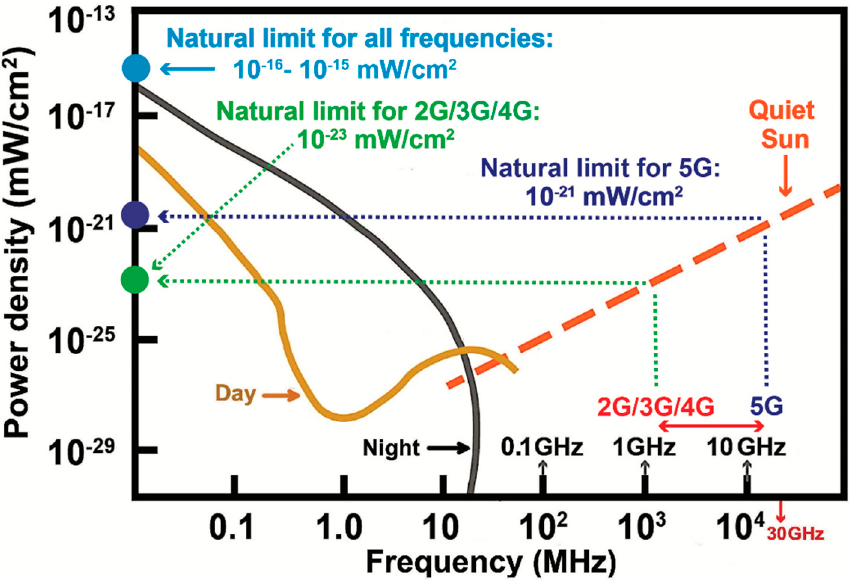
Figure 1. Day and night natural limit of power density (mW/cm 2 ) of EMR emitted by the reaching Earth’s surface in the microwave spectral regions, from 0.1 to 3 × 10 4 MHz. The associated Sun and reaching Earth’s surface in the microwave spectral regions, from 0.1 to 3x10 4 power density natural limit of ~10 − 23 to 10 − 21 mW/cm 2 is compared with the ICNIRP exposure MHz. The associated power density natural limit of ~10 − 23 to 10 − 21 mW/cm 2 is compared limit of ~1 mW/cm 2 for man-made microwave sources. The ICNIRP/FCC thermal exposure limit for with the ICNIRP exposure limit of ~1 mW/cm 2 for man-made microwave sources. The man-made EMR is ~10 21 - to 10 23 -fold higher than the natural microwave radiation limit at Earth’s ICNIRP/FCC thermal exposure limit for man-made EMR is ~10 21 - to 10 23 -fold higher than surface of single microwave frequencies from the Sun (the plot is an extensive modification of that in NASA’s report CR 166661 [10]).